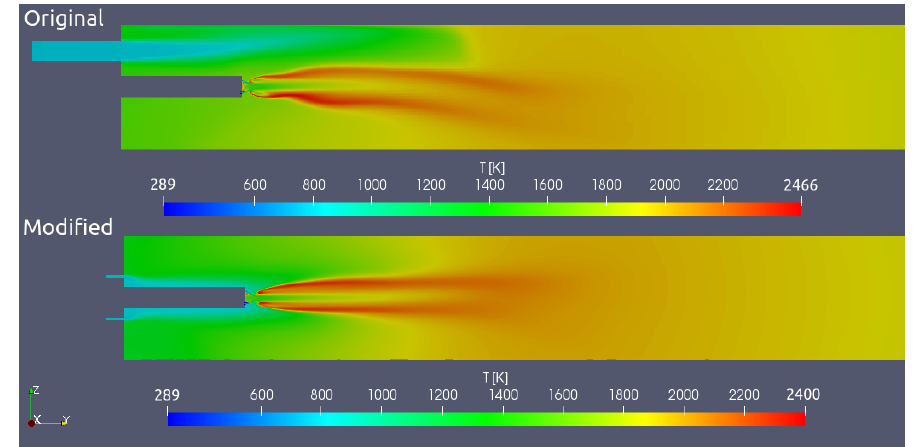
Figure 7. Computed temperature in K on the central axial slice for the original rectangular ( top ) and modified annular ( bottom ) secondary air inlet. A volumetric air–fuel ratio equal to nine is used. Different scales are chosen to highlight the maximum